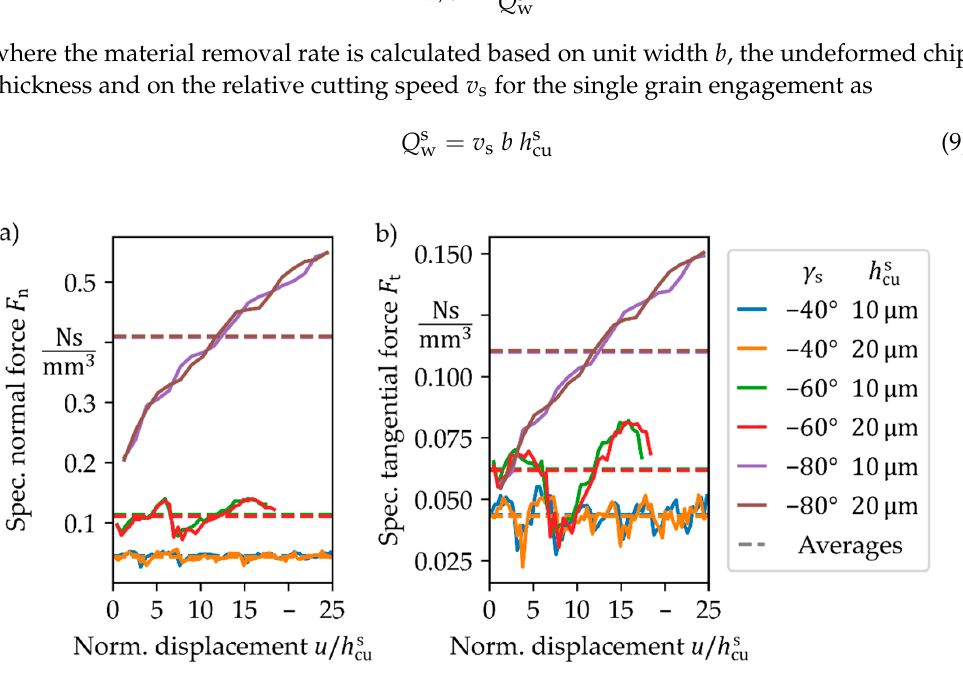
Figure 7. Exemplary specific ( a ) normal and ( b ) tangential force curves, for multiple combinations of rake angle γ s and undeformed chip thickness h s cu , obtained from single grain FE simulations. The displacements are normalised by h s cu . Dashed lines indicate average values for each